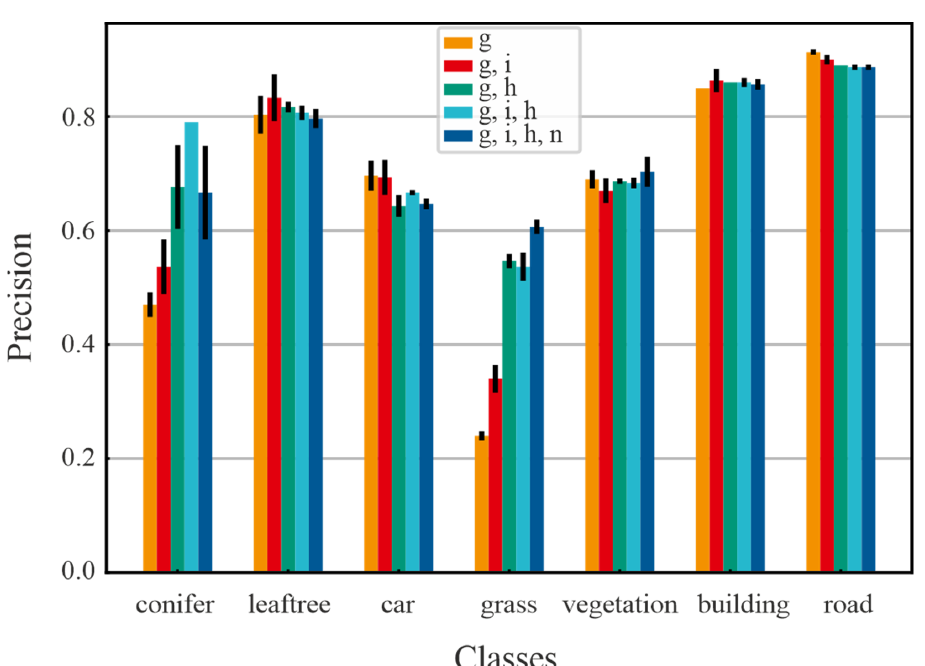
Figure A1. Visualization of the training results. Here the precision of each class is shown for the training using just geometry (g), geometry and intensity (g, i), geometry and DAV (g, h), geometry, intensity and DAV (g, i, h) and geometry, intensity, DAV and number of points (g, i, h, n). The black bars indicate the standard deviation calculated from the three separate trainings for each setting.